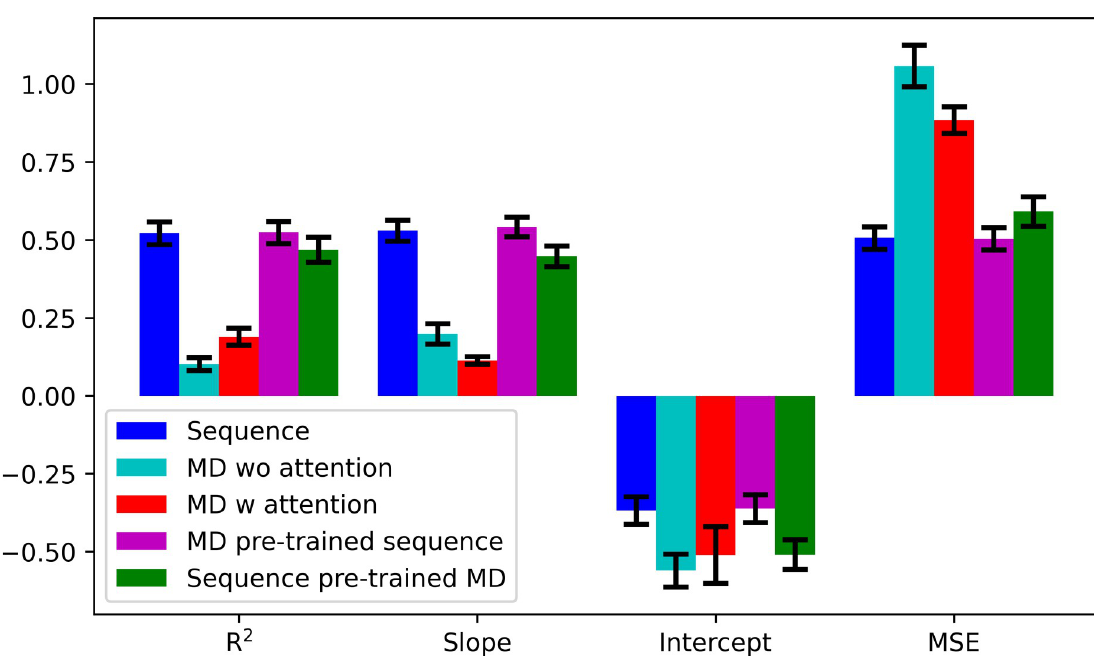
Fig 5. Performance of phenotype predictions from sequence and MD data based on linear regression R 2 correlation coefficients, slope and intercept of linear regression curves, and mean squared errors (MSE) between given and predicted phenotypes. Every metric was calculated as the average over 10